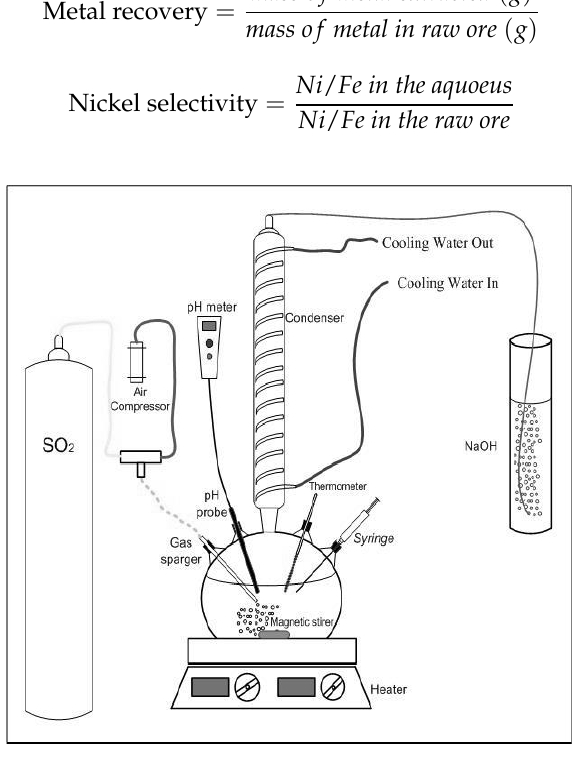
Figure 1. Experiment setup for nickel leaching.